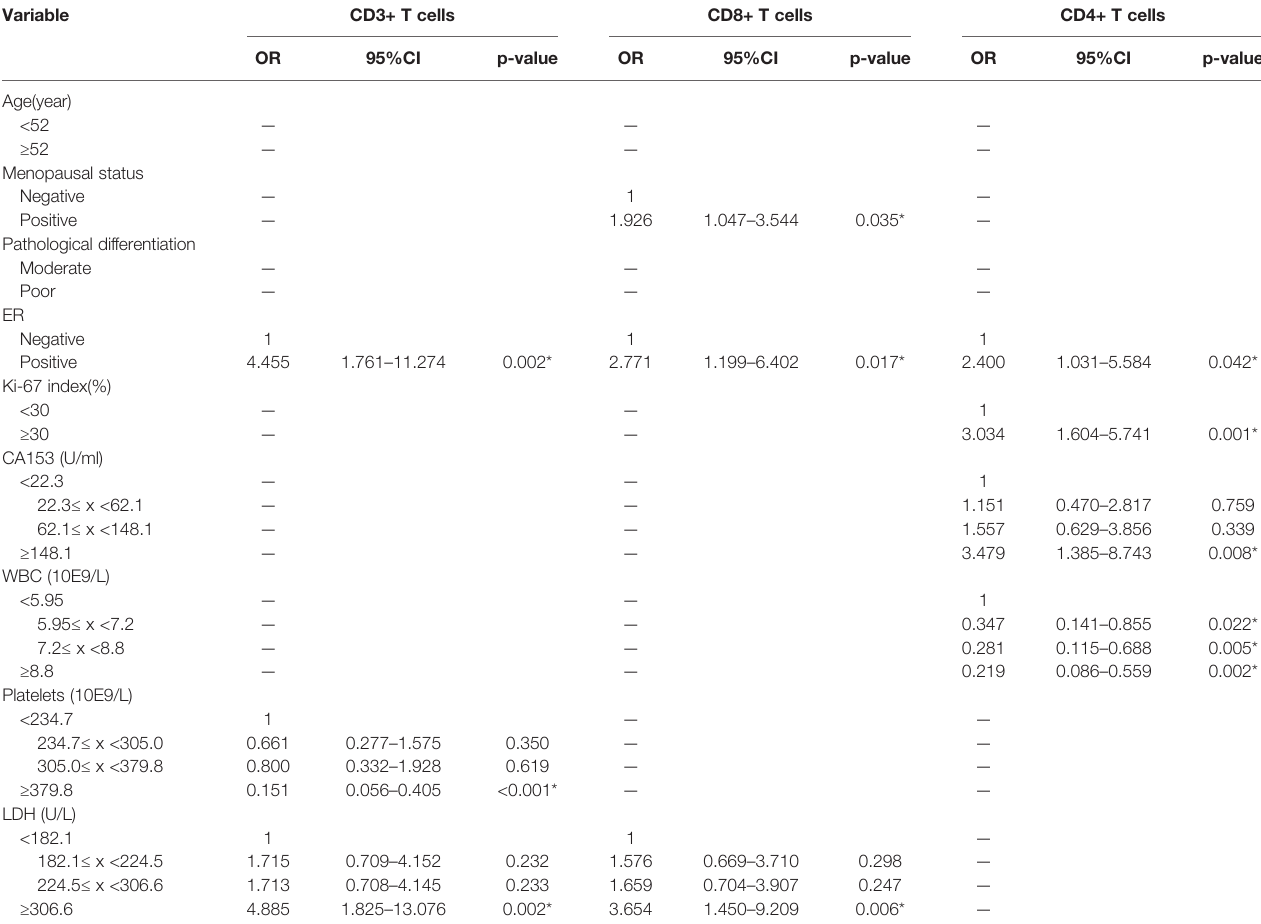
TABLE 6 | Correlative factors for tumor in fi ltrating T cells identi fi ed by multivariate logistic regression analysis. Variable